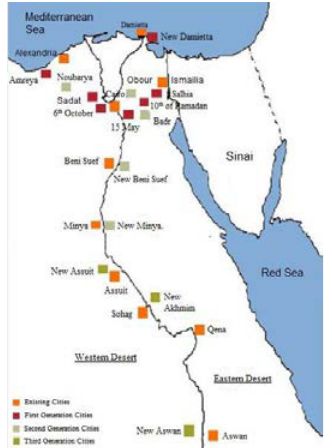
Figure 2: an Illustrative map for the distribution of new cities in Egypt, according to three generations. Source: the two